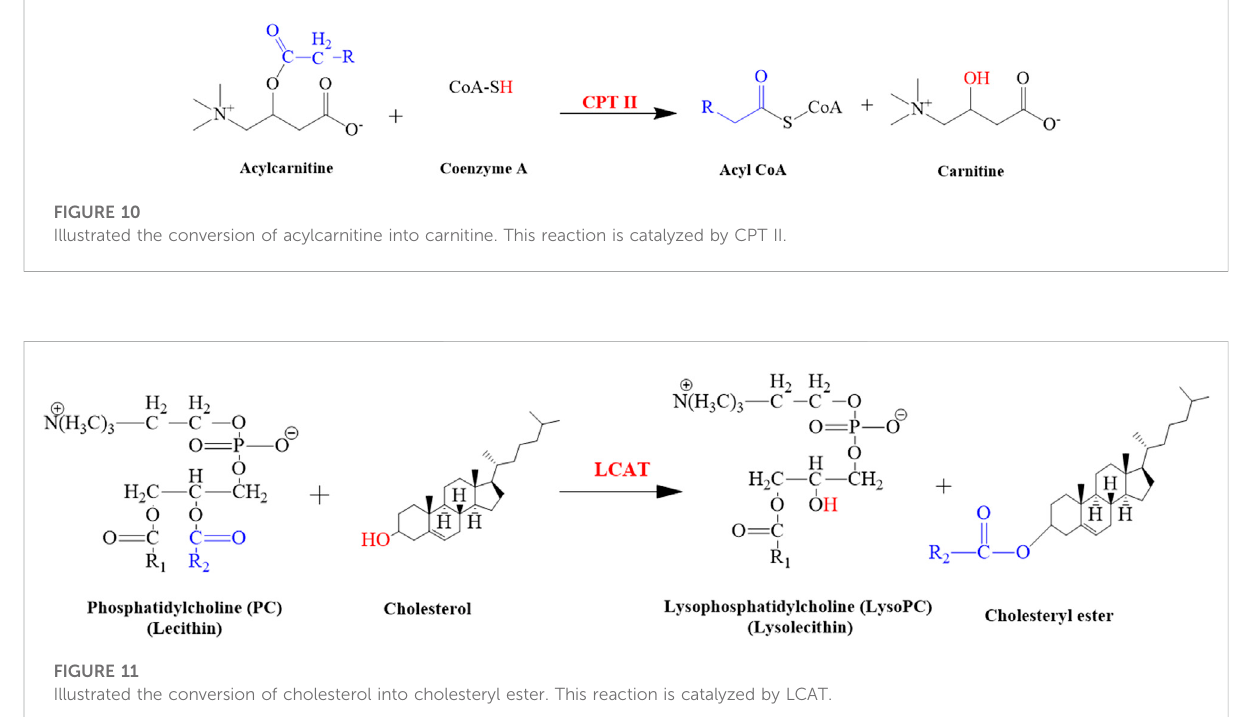
Frontiers in Molecular